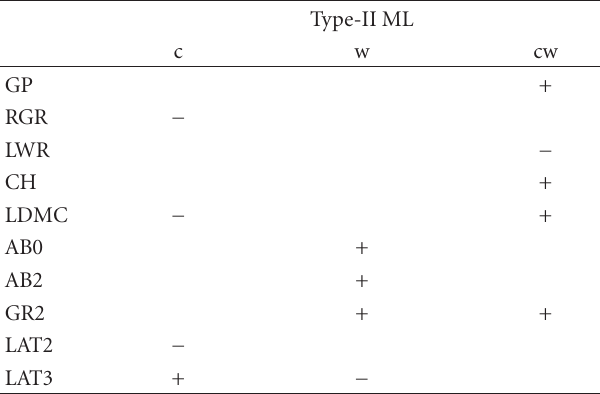
Table 4: Trait-environment interactions from Type-II that were not common to other methods.